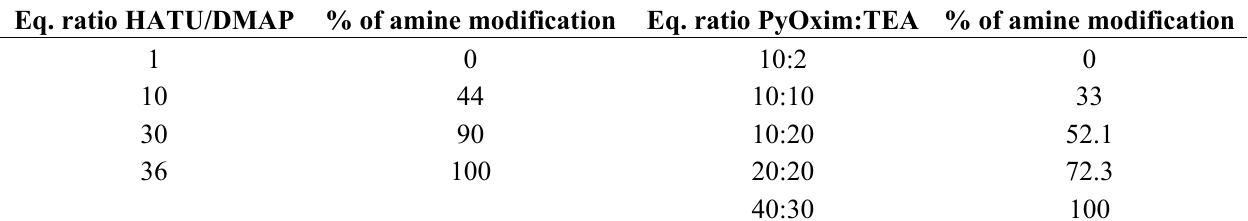
Table 1. Equivalents of coupling reagents used for PNA-PEO solution coupling and degree of amine conversion